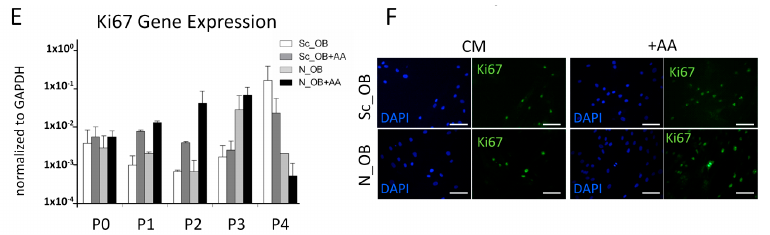
Figure 1. Effect of ascorbic acid-2-phosphate (AA) on the outgrowth and proliferation of osteoarthritic osteoblasts (OB). ( A ) The number of outgrowing cells from subchondral bone chips from sclerotic (Sc_OB) and non-sclerotic regions (N_OB) was quantified and normalised per gram of bone tissue in standard culture medium and in the presence of AA (+AA; for n = 5–7 donors/experimental group, analysed in triplicates for each donor); ( B ) Expression profile determined by FACS of alkaline phosphatase (ALP) and osteocalcin (OC) in isolated Sc_OB and N_OB, following outgrowth (P0) in the absence (CM) or presence of AA (+AA); ( C ) Proliferation rate, defined by the number of population doublings (PD)/day, of expanded Sc_OB and N_OB ( n = 7 donors, analysed in duplicates for each donor); ( D ) Total number of population doublings before ceasing proliferation by the end of passage 4; ( E ) Expression of the proliferation marker Ki67 at the mRNA level (normalised to the housekeeping gene GAPDH) and ( F ) at the protein level in P2 expanded cells, determined by immunofluorescence. Scale bar = 100 µm. Data in ( A , C – D ) are presented as mean ± SD (standard deviation). Sc_OB = sclerotic osteoblasts; N_OB = non-sclerotic osteoblasts; CM = culture medium; +AA = culture medium supplemented with 0.1 mM ascorbic acid. * indicates statistically significant differences ( p <